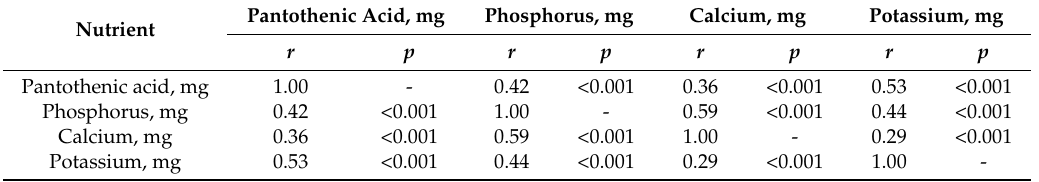
Table A1. Correlation between nutrient intakes of participants from the PROGREDIR study.